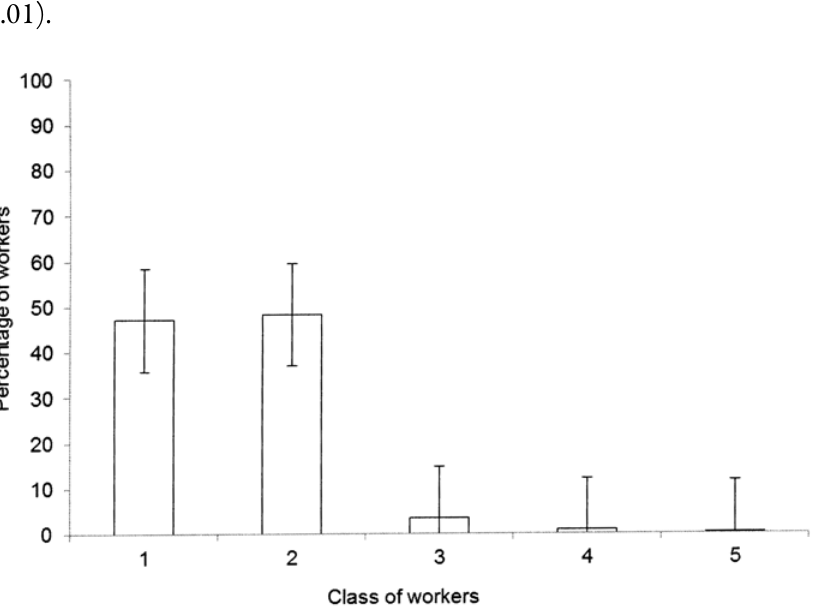
Fig. 1. Percentage (± SE) of workers of Atta robusta of different size classes that foraged during one year in restinga ecosystem from Grussaí/Iquipari complex. Class 1 (head capsule 1 to 2 mm), class 2 (head capsule 2.1 to 3 mm), class 3 (head capsule 3.1 to 4 mm), class 4 (head capsule 4.1 to 5 mm) and class 5 (head capsule ( ≥ 5.1